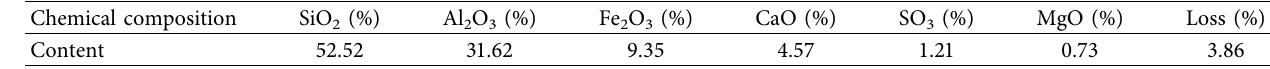
Table 2: Chemical composition of fly ash.